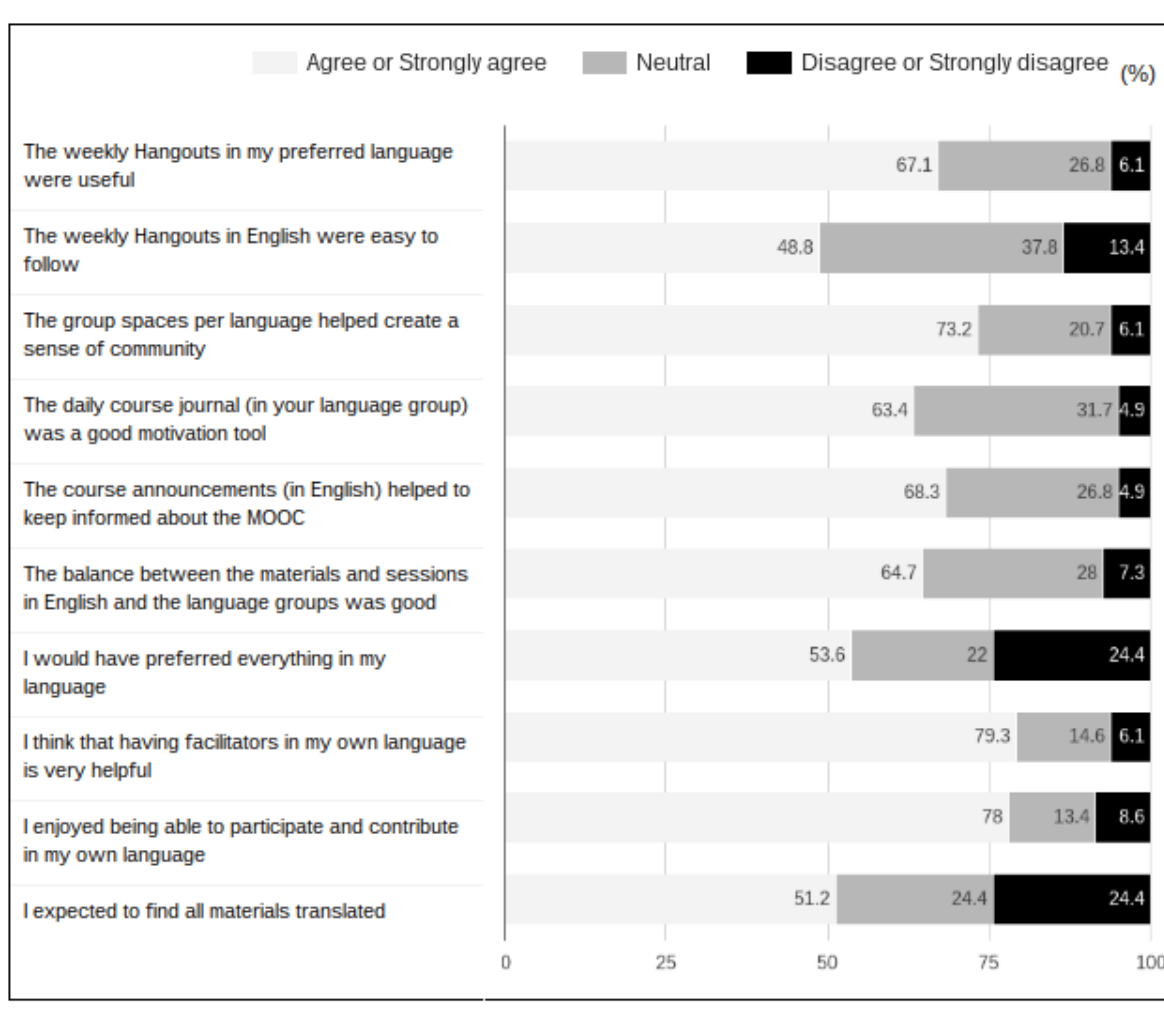
Figure 11 . Results of the survey of the participants about